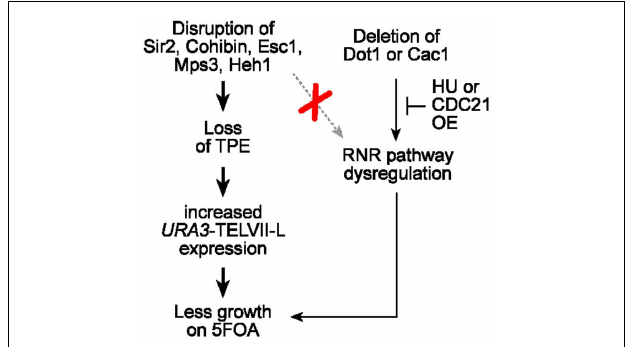
FIGURE 6 | Perinuclear telomere tethers impact the telomeric URA3 /5FOA reporter system as a result of changes toTPE and not nucleotide metabolism. Unlike dot1 ∆ or cac1 ∆ cells, RNR expression is unaffected in cells lacking various perinuclear telomere tethering factors including Sir2, cohibin, Esc1, Mps3, and Heh1. In addition, the 5FOA sensitivity of URA3 -TELVII-L-harboring cells that lack these telomere-associated factors, but not Dot1/Cac1, is not restored upon RNR inhibition, which can be achieved via defined HU treatments or CDC21 overexpression.Thus, the effects of major telomere tethering factors in telomeric URA3 /5FOA reporter systems assaying forTPE reflect changes to chromatin assembly and gene expression but not nucleotide